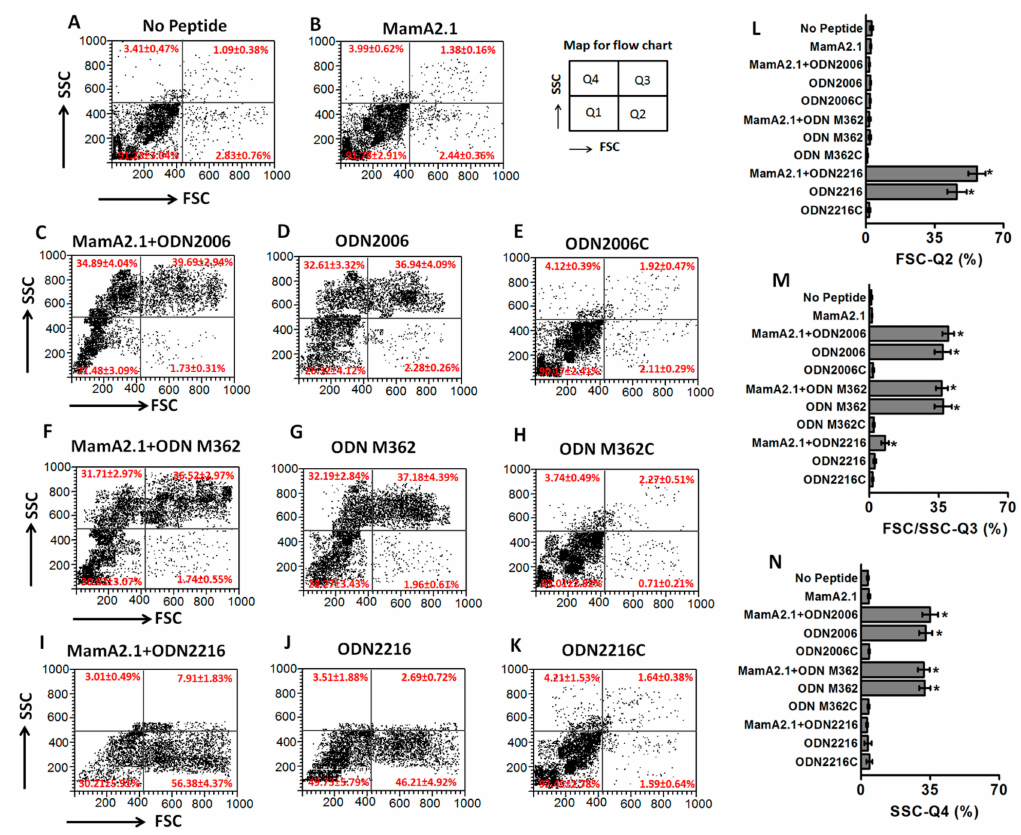
Figure 2. Di ff erential phenotypic changes of THP-1 cells following stimulation with the three ODNs. THP-1 cells were analyzed by flow cytometry under regular culture conditions ( A ), following stimulation with the MamA2.1 peptide (10 µ g / mL) ( B ), combination of MamA2.1 + ODN2006 ( C ), ODN2006 alone ( D ), negative control for ODN2006—ODN2006c ( E ), combination of MamA2.1 + ODN M362 ( F ), ODN M362 alone ( G ), negative control for ODN M362–ODN M362c ( H ), combination of MamA2.1 +